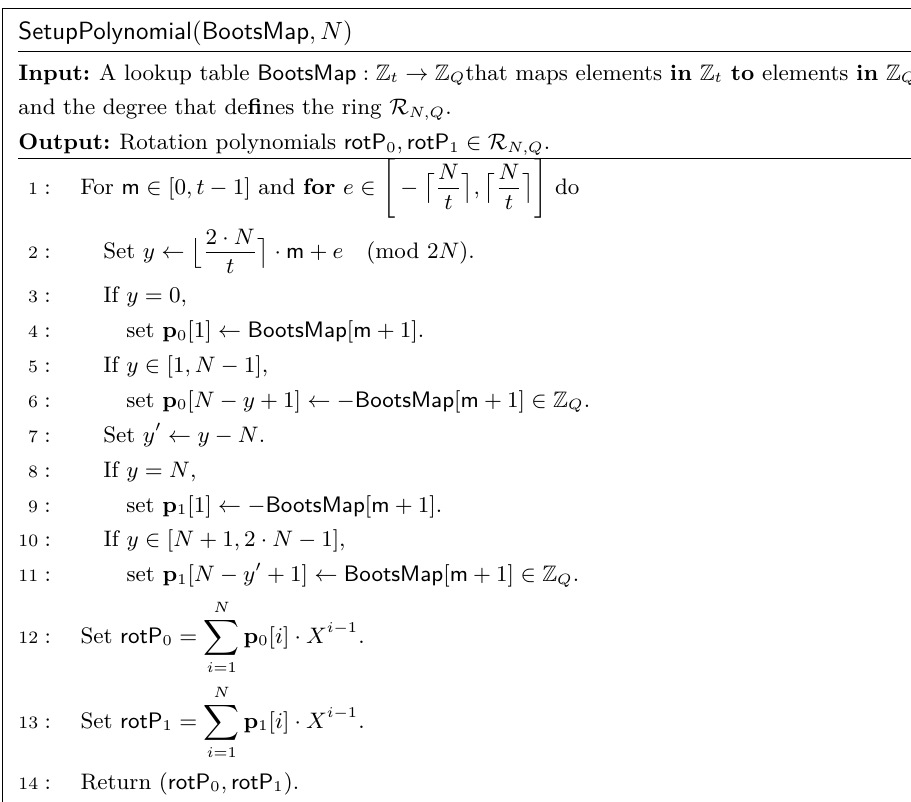
SetupPolynomial ( BootsMap , N )